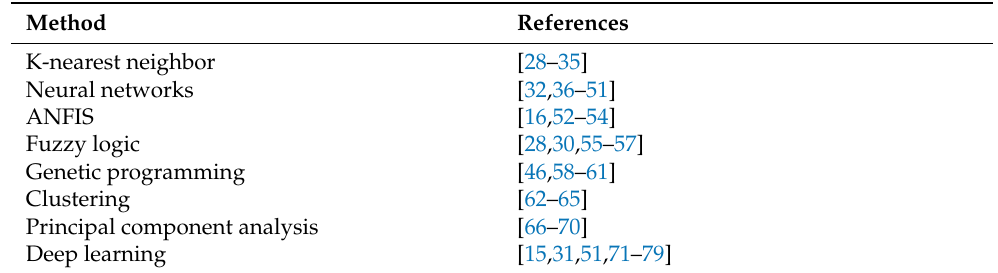
Table 1. Related works on PD diagnosis.